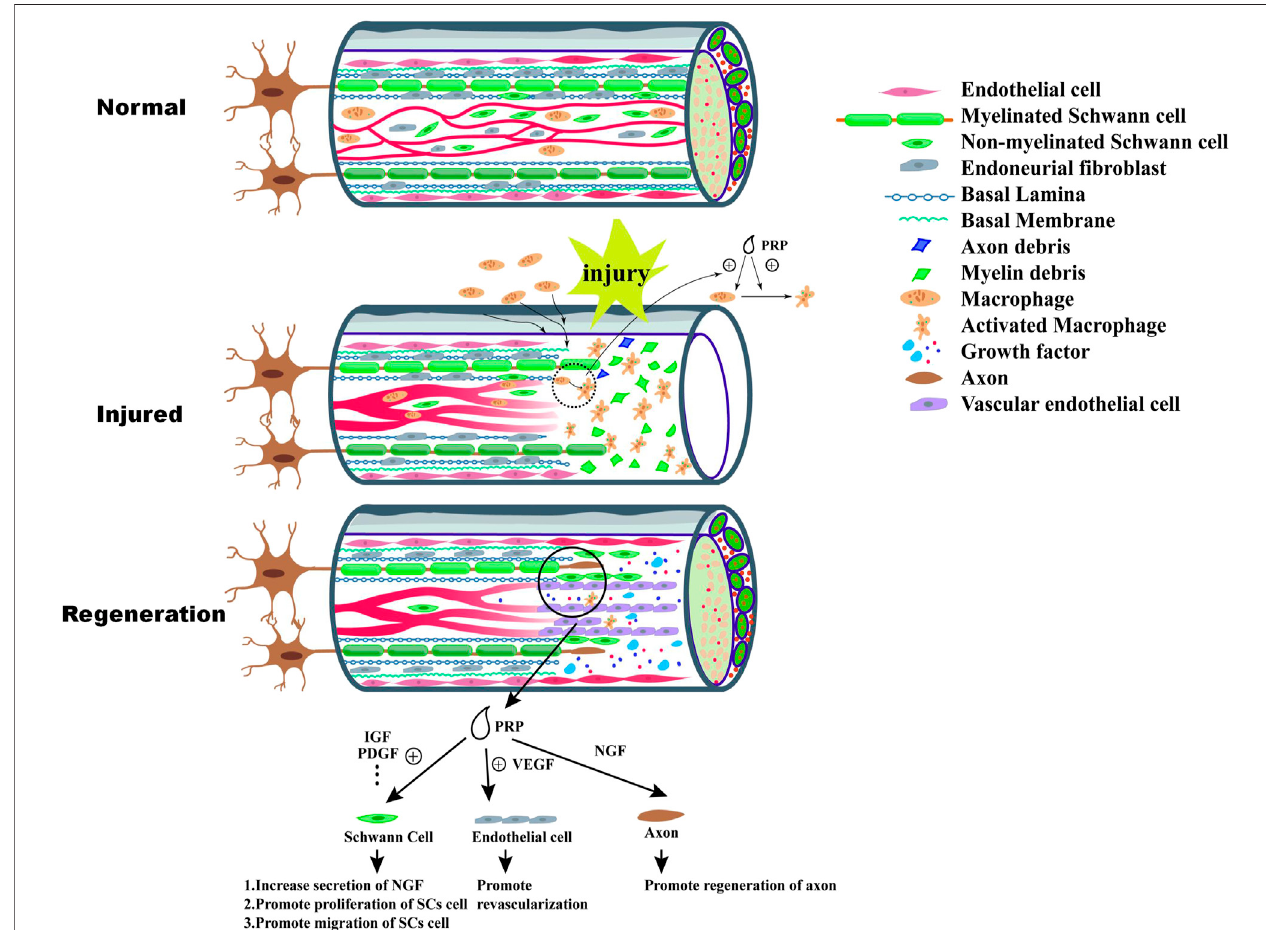
FIGURE 1 | Wallerian degeneration happens after injury of peripheral nerve, which include disintegration of axon and nerve demyelination at the distal end. The debris of nerve tissue are engulfed by macrophages recruited from peripheral blood or nerve tissue, which can provide a suitable environment for nerve regeneration. Monocyte chemoattractant protein-1 (MCP-1) secreted by Schwann cells promote recruitment of macrophages. PRP exert positive effect on recruitment and polarization of macrophage. After Wallerian degeneration, the process of nerve tissue regeneration begin. VEGF-A released by Schwann cell and activated macrophage play a signi fi cant role in the process of the formation of neovessels which supply oxygen and nutrients to the formation of “ bands of Bünger ” . At the same time, intact Schwann cells secrete nerve growth factor (NGF), brain-derived neurotrophic factor and glia-derived neurotrophic factor (GDNF) which stimulate the proliferation of Schwann cell and formation of “ bands of Bunger ” . As the formation of neovessels, Schwann cells migrate along the vascular which also guide regeneration of axon. PRP contain high concentration of various growth factor which can promote effectively biological activity of Schwann cells, such as migration, secretion of NGF and proliferation. Additionally, high concentration of VEGF in PRP can improve revascularization.